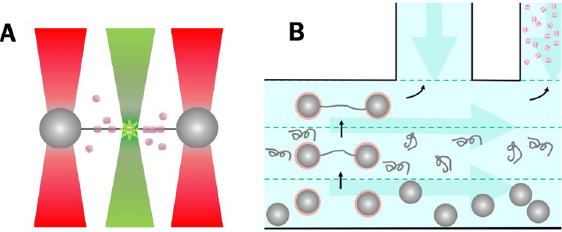
Figure 1. Schematic illustrating the experimental layout of an experiment using confocal optical tweezers. ( A ) Alexa555-labelled HU proteins (pink spheres) are excited at 532 nm. Fluorescence emission is measured at 555 nm. ( B ) A top view of a microfluidic sample chamber with laminar flow. DNA was captured between beads, and HU–DNA complexes were assembled inside the protein channel and in the presence of flow. The measurements were carried out inside one of the two top channels without